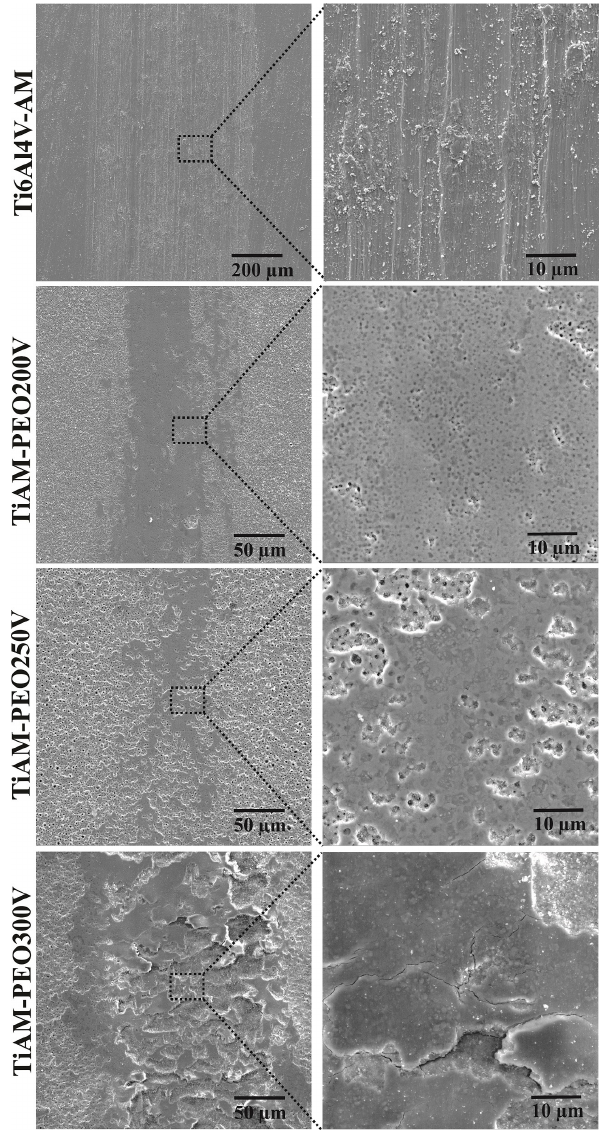
Figure 5. SEM/EDS of the wear tracks generated in the tribological test on coatings obtained by PEO on Ti-6-Al-4-V ELI alloy additively manufactured.